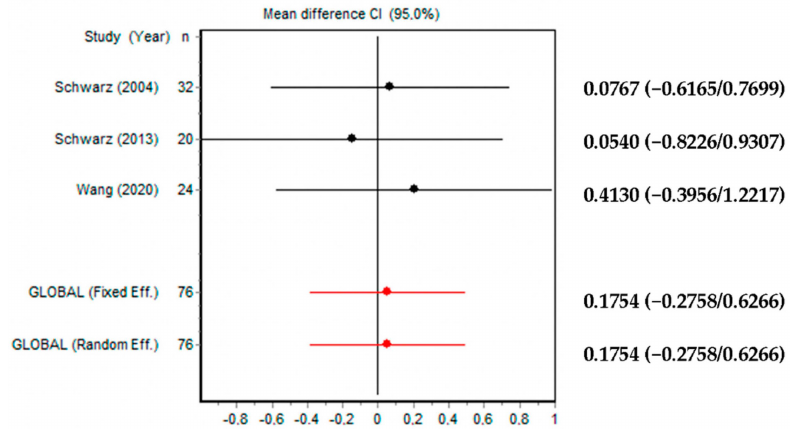
Figure 2. Forest plot for CAL gain mean (Er:YAG laser vs. conventional mechanical